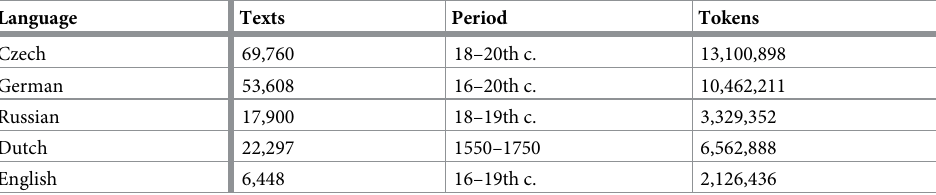
Table 3. Summary of poetry corpora